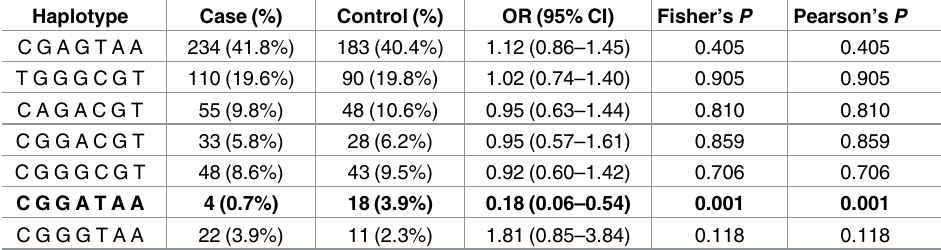
Associations that reached statistical significance were highlightedin bold.